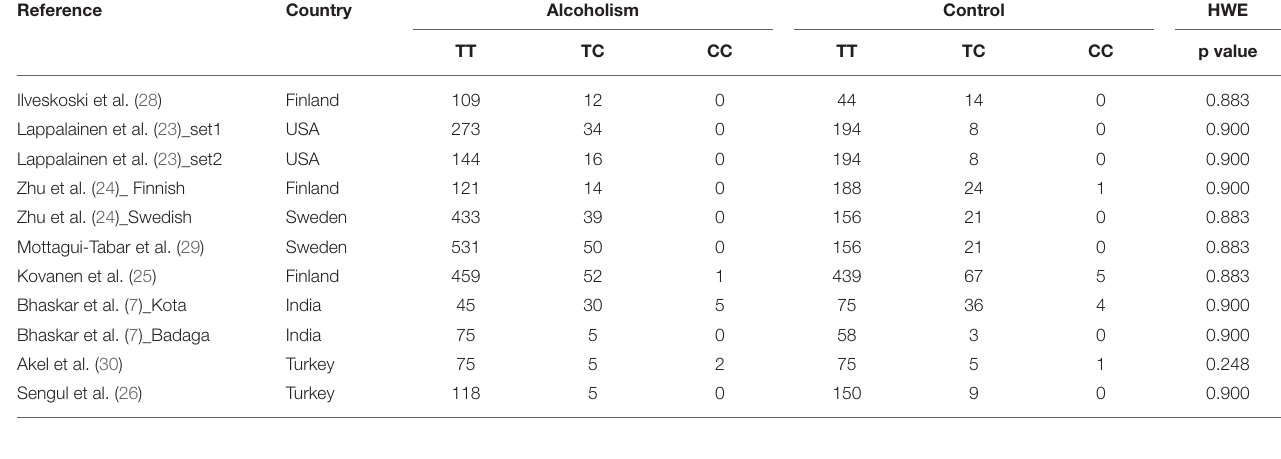
TABLE 1 | Summary of characteristics of included